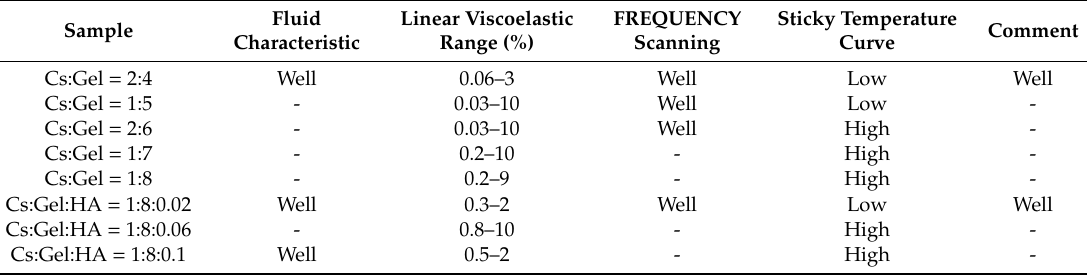
Table 5. Summary of fluid properties of various ratios of